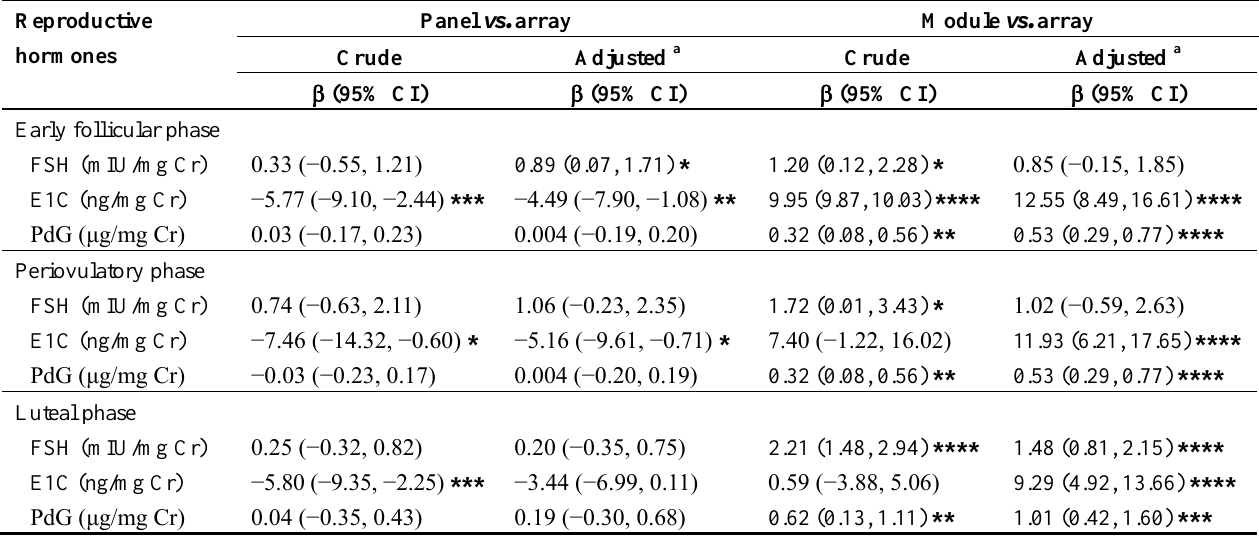
Table 4. Associations between work areas and reproductive hormones in each phase of the menstrual cycle